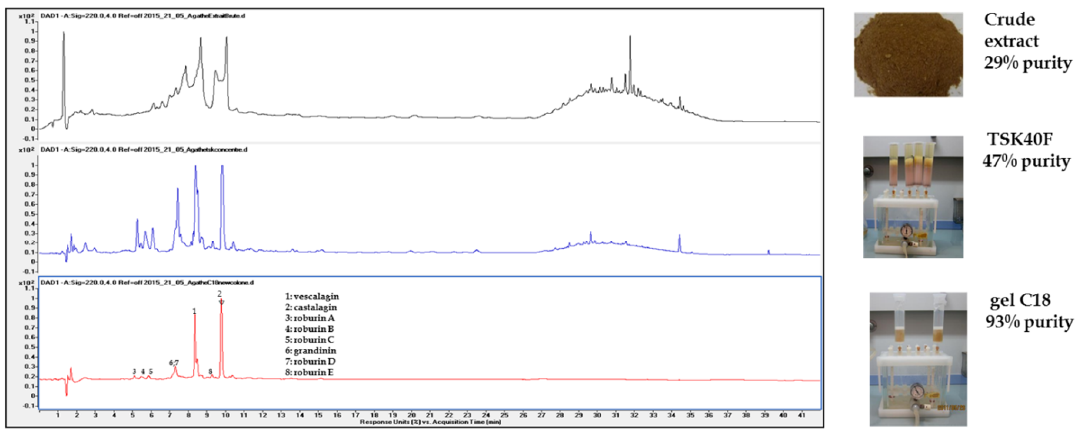
Figure A2. Purification steps of oak wood ellagitannins.